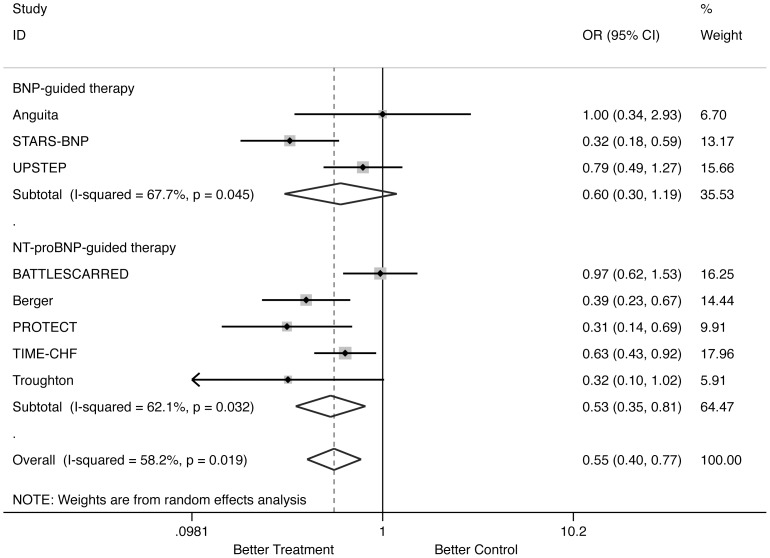
Odds ratios of heart failure-related hospitalization.Solid squares represent odds ratios in trials and have a size proportional to the number of events. The 95% confidence intervals for individual trials are denoted by lines and those for the pooled odd ratios by empty diamonds.